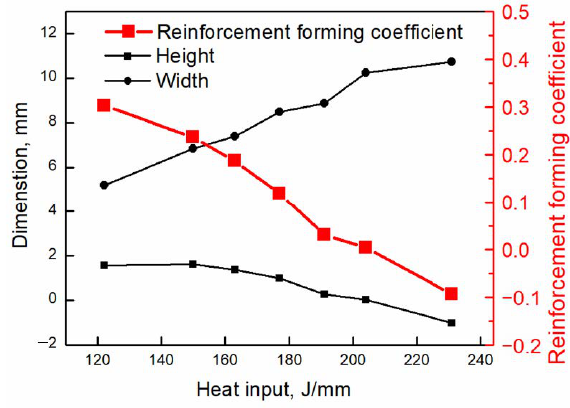
Figure 5. Coefficient of bead reinforcement with heat input.